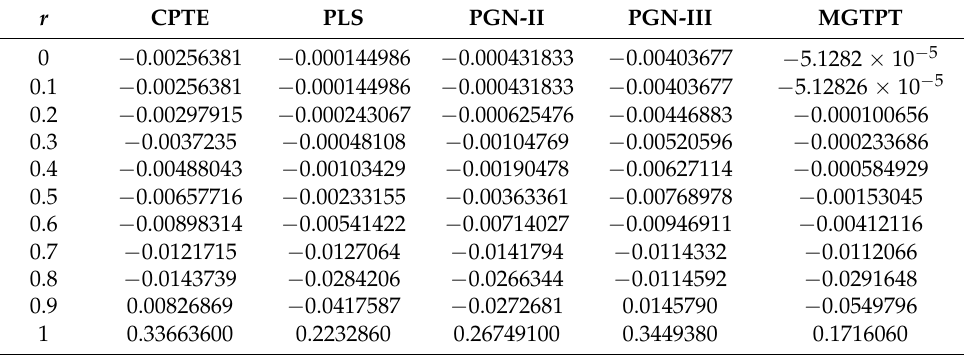
Table 3. The carrier density variation N under photothermal models.